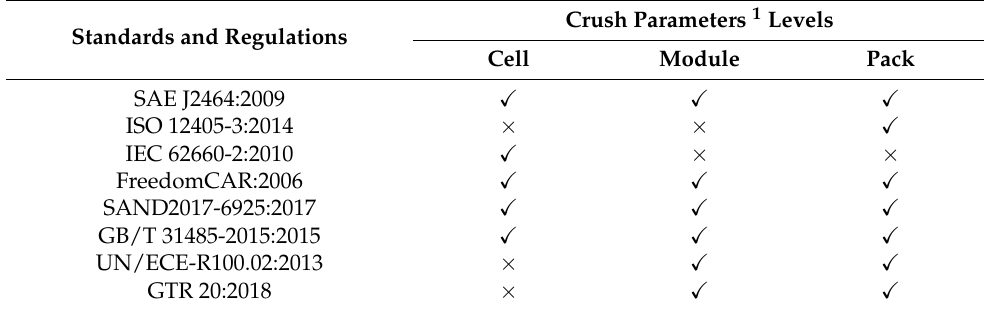
Table 9. Ambiguity in standards and regulations for crush parameters different